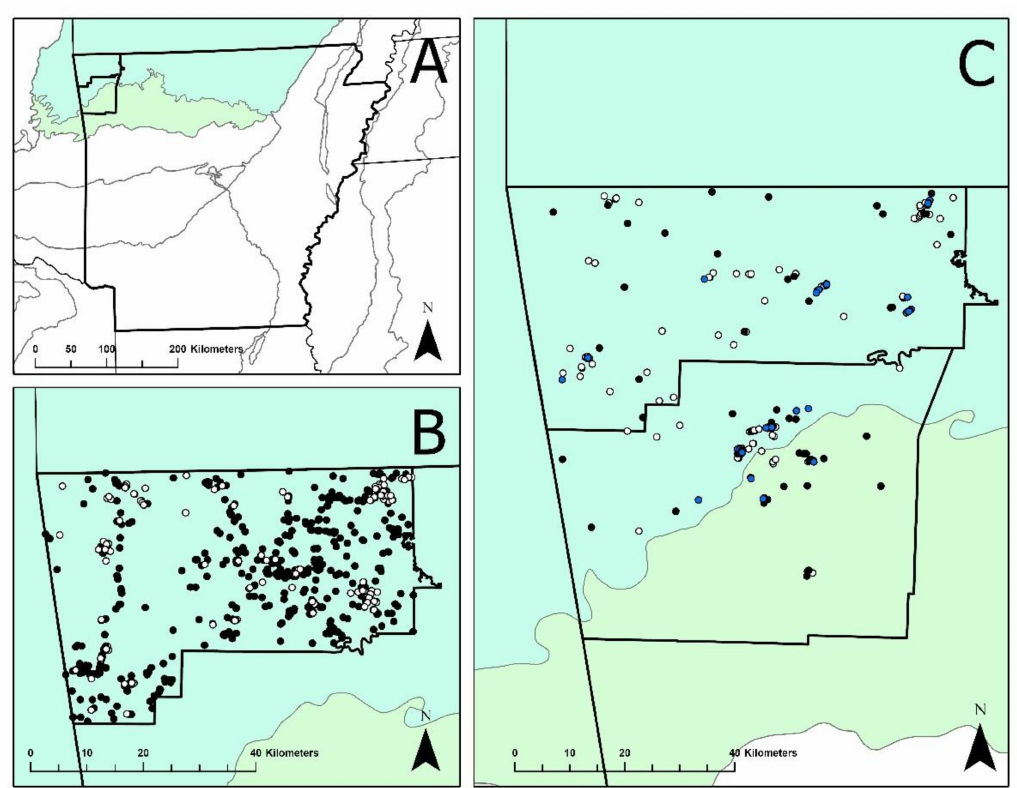
Figure 1. Maps of ( A ) the study area in Northwest Arkansas, USA, and its ecoregion context of the Ozark Highlands (north—blue) and Boston Mountains (south—green) [37], ( B ) the Benton County georeferenced points with point data from before the project in white (557 points, 17%) and generated through the project in black (2636 points, 83%), and ( C ) element occurrence records (EORs) of tracked taxa identified on iNaturalist from Benton and Washington Counties with pre-existing EORs in white, updated EORs from iNaturalist observations in blue, and new EORs from iNaturalist observations in